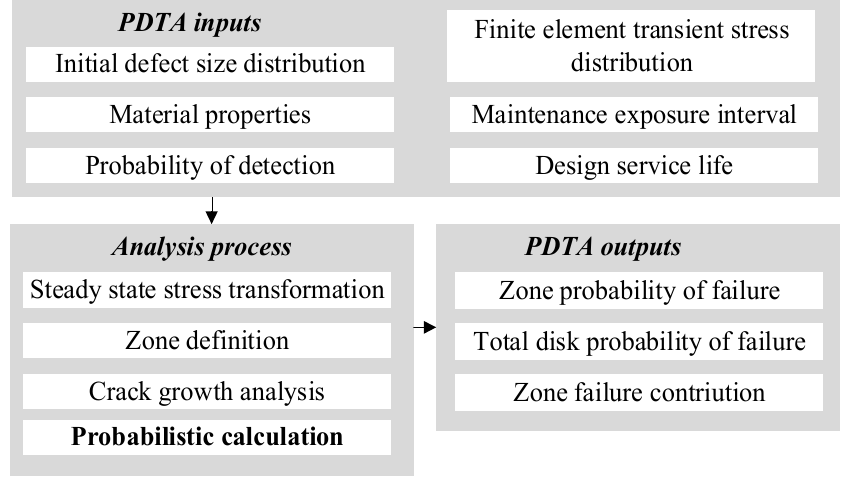
Figure 1. Initial defect distribution curve.